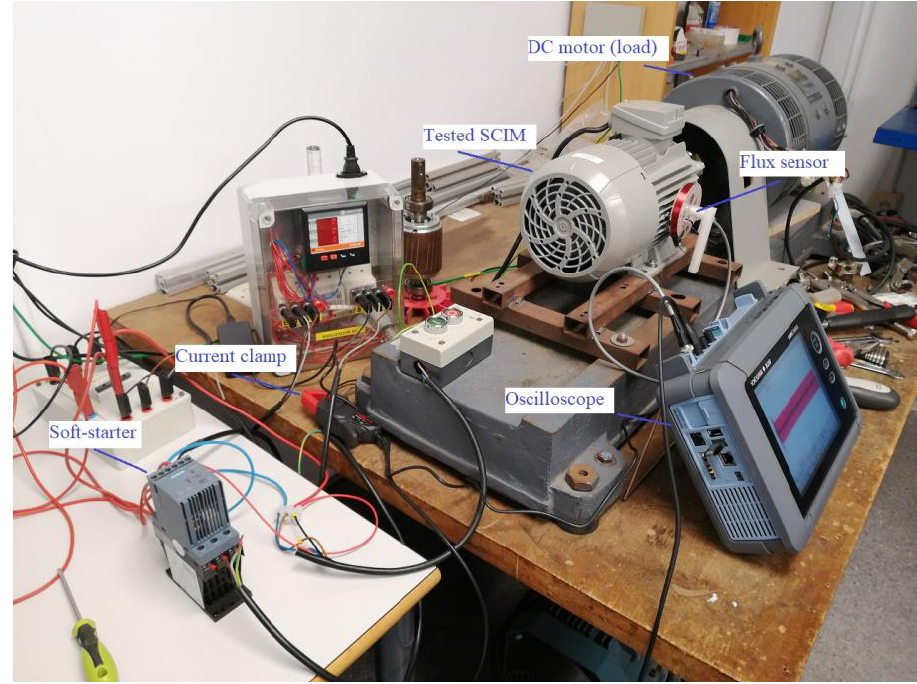
Figure 9. Test-bench used in the laboratory.